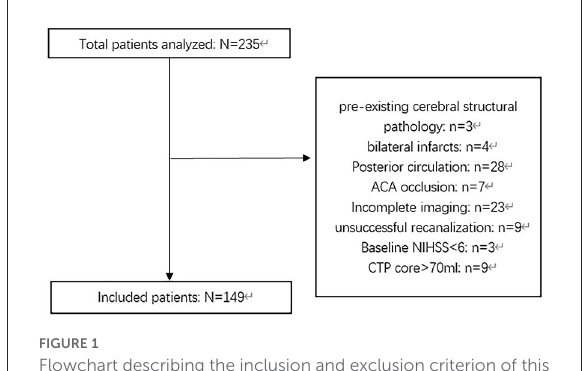
FIGURE1 Flowchart describing the inclusion and exclusion criterion of this study. NIHSS, National Institute of Health Stroke Scale; ACA, anterior cerebral artery; OTP, Time from onset to puncture; CTP,